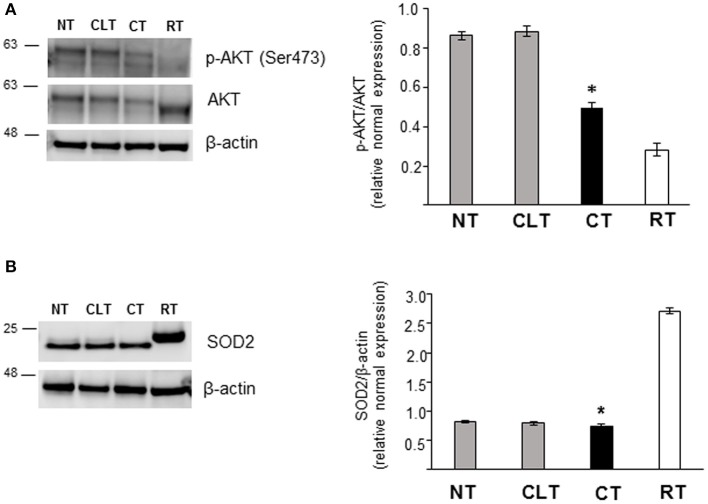
Western blot analysis of phospho-AKT, AKT, and SOD protein expression in normal, cryptorchid, and contralateral dog testis. (A) Phospho-AKT/AKT and (B) SOD2 proteins are evidenced respectively as a band of 60 and 22 kDa in all the tested tissues. Densitometric analysis shows a significant decrease in both protein expression level in CT compared with NT and CTL. Samples from rat testis (RT) were blotted as positive controls. Data are expressed as mean ± SD (n = 5 samples/group), *p < 0.01.